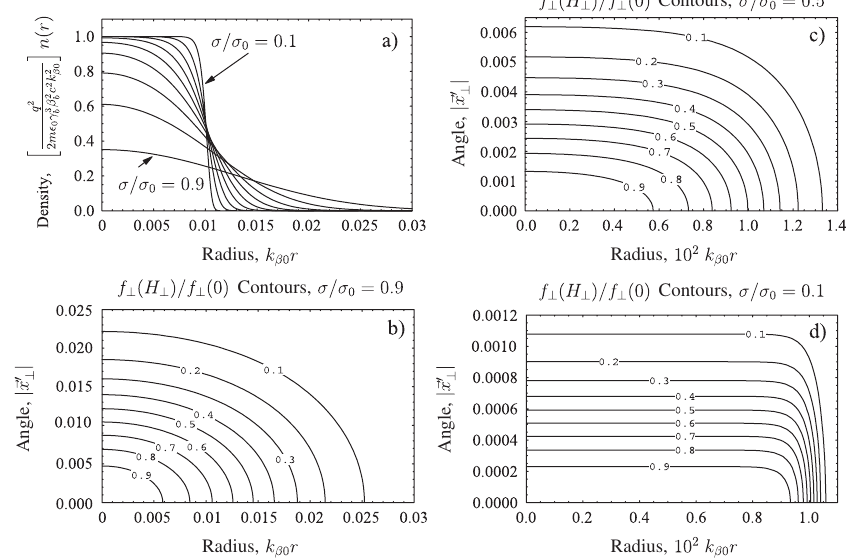
¼ const ) and perveance Q ¼ FIG. 19. Thermal equilibrium distribution in continuous-focusing field for fixed focusing strength ( k 2 (cid:5) 0 Þ(cid:6) n ð r Þ is plotted versus the dimensionless radial m(cid:8) 3 (cid:5) 2 c 2 k 2 10 (cid:1) 4 (rms-equivalent beam measure). In (a) the scaled density ½ q 2 = ð 2 (cid:7) 0 (cid:5) 0 b b ¼ 0 : 9 ; 0 : 8 ; . . . ; 0 : 1 , and in (b), (c), and (d), the normalized distribution r for relative space-charge strengths (cid:3)=(cid:3) coordinate k (cid:5) 0 0 j for (cid:3)=(cid:3) ¼ 0 : 9 , 0.5, and 0.1. Contours are labeled by the f ? ð H ? Þ =f ? ð 0 Þ ¼ const contours are plotted as a function of k r and j x 0 (cid:5) 0 0 ? value of f ? ð H ? Þ = ^ f ? . Values of (cid:3)=(cid:3) correspond to the dimensionless equilibrium parameters in Table V. 0 To better understand properties of the thermal equilib- rium, we employ Eqs. (F17) and (F18) to plot the radial density profile and the phase-space distribution in Fig. 19 ¼ const ) and fixed for fixed applied-focusing strength ( k 2 (cid:5) 0 beam perveance ( Q ¼ const ) as the relative space-charge strength ( (cid:3)=(cid:3) ) is varied. In Fig. 19(a) the scaled radial 0 density is plotted. For thermal equilibrium, the tempera- ture profile is spatially uniform with ð H Þ =f ð 0 Þ are shown in the scaled distribution f ? ? ? corresponding to Figs. 19(b)–19(d) for values of (cid:3)=(cid:3) 0 weak, intermediate, and strong relative space-charge inten- sity. Various parameters for the equilibria presented in